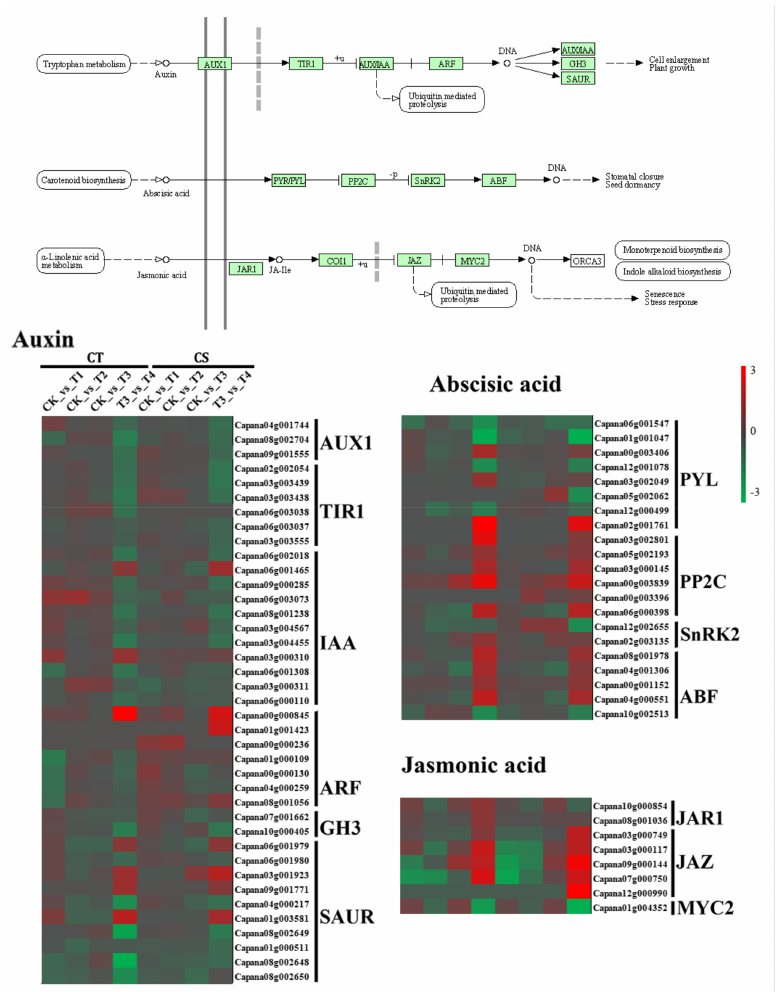
Figure 5. DEGs involved in plant hormone signal transduction pathway. DEGs shared in auxin, abscisic acid (ABA), and jasmonic acid (JA) signal and comparison of their expression patterns in CT and CS. The log2FC values were used for mapping. Red color represents high gene expressions; green color represents low gene